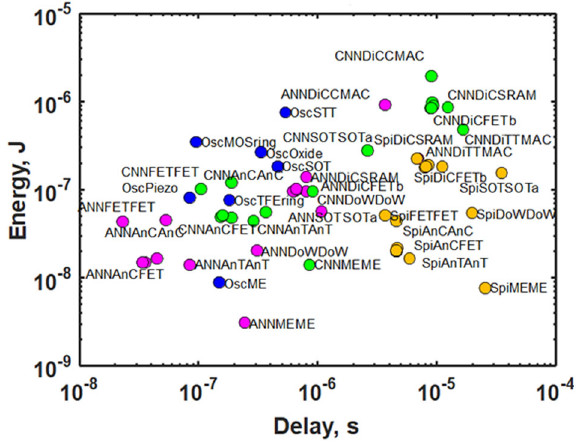
Fig. 5 Energy vs. delay for one inference in a circuit implementing the LeNet convolutional neural network. Arti fi cial neural networks (ANN, magenta dots), cellular neural networks (CNN, green dots), spiking neural networks (SNN, Spi (gold dots)), oscillator neural networks (ONN, Osc (blue dots)). Labels for device-architecture combinations include DiC: digital CMOS, AnC: analogue CMOS, FET: ferroelectric transistor, STT: spin-transfer torque, SOT: spin – orbit torque, DoW: domain wall motion, ME: magnetoelectric switching. Reproduced from ref. 50 .